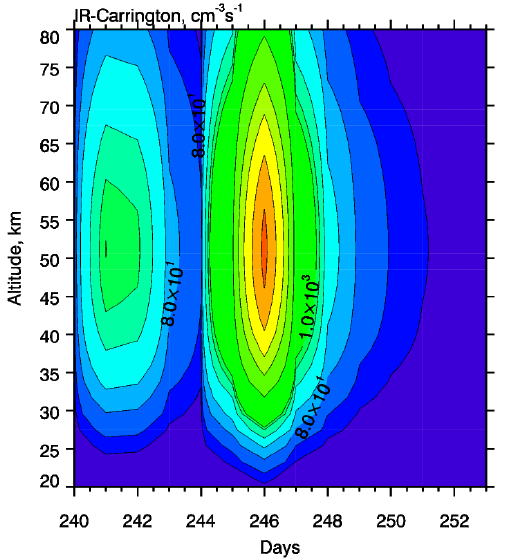
428 Fig. 1: Height versus time evolution of ionization rates for the investigated Carrington-like solar pro- 429 ton event. The particular shape with two major episodes within 5 days is taken from the event of 430 Fig. 1. Height versus time evolution of ionization rates for the inves- August 1972. Contour levels: 0, 5, 20, 80, 200, 500, 800, 1’000, 4’000, 8’000, 12’000, 18’000, 431 tigated Carrington-like solar proton event. The particular shape with 25’000, 30’000 ion pairs cm -3 s -1 . 432 two major episodes within 5 days is taken from the event of August 1972. Contour levels: 0, 5, 20, 80, 200, 500, 800, 1000, 4000, 8000, 12000, 18000, 25000, 30000 ion pairscm − 3 s − 1 .